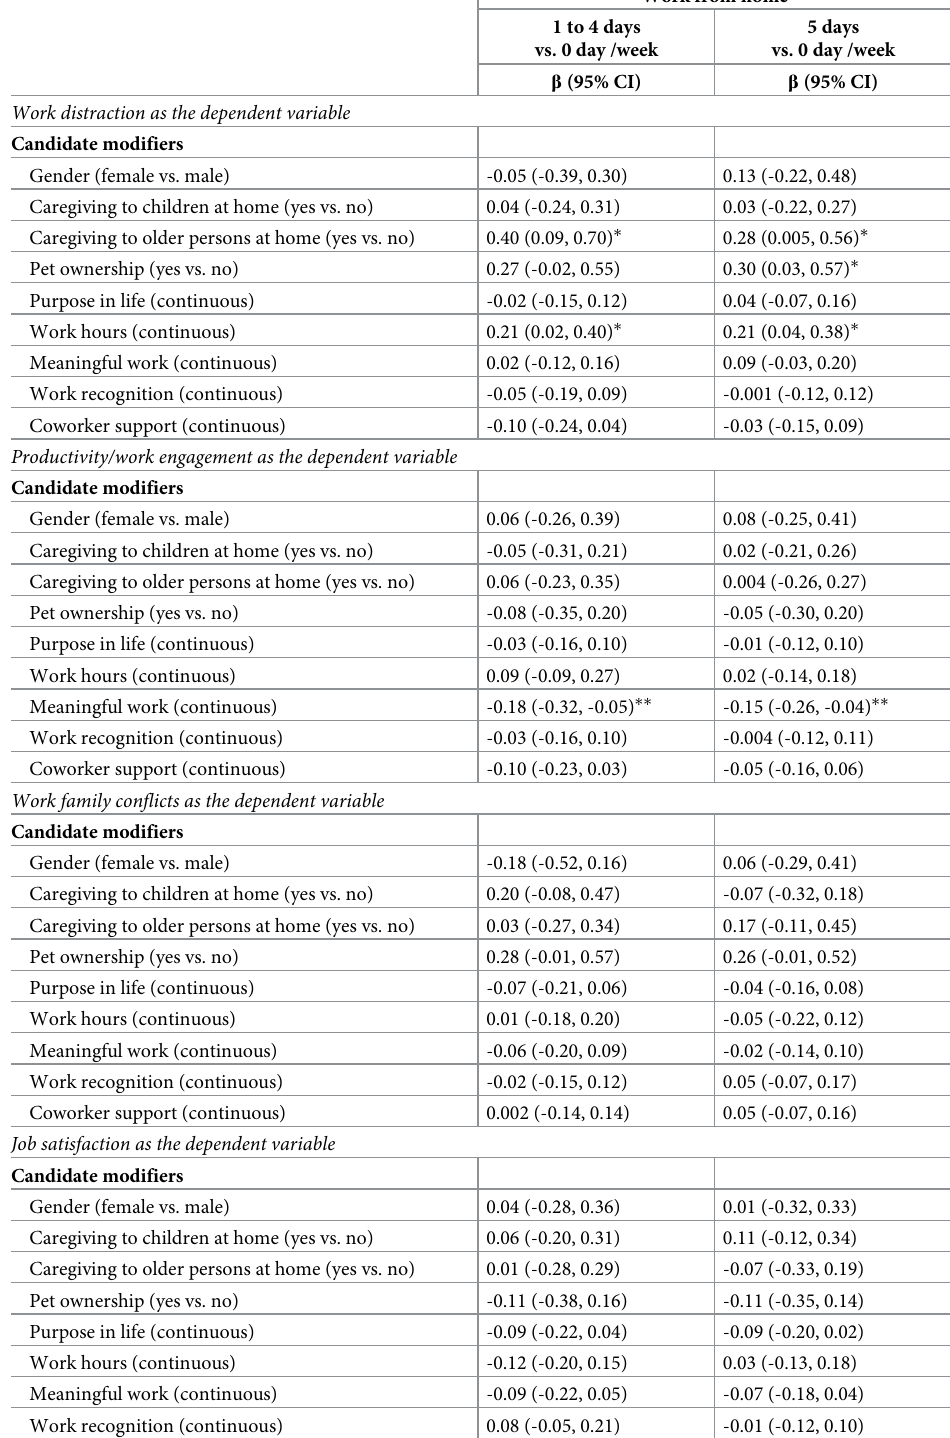
Table 3. Interaction terms between work from home and candidate modifiers for the associations between work from home and subsequent work outcomes (N =